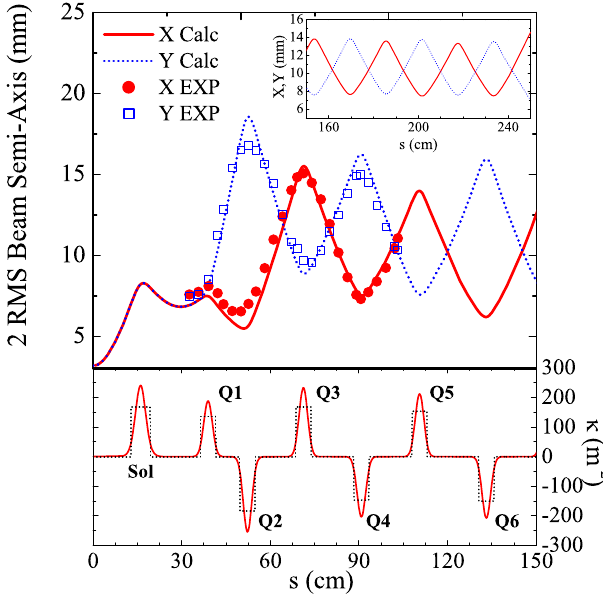
V).FIG. 8. (Color) Envelope-matching calculations for (cid:5) 72 : 92 (cid:12) (from SPOT ) vs experimental beam dimensions for a 100 mA, 10 keV, (cid:4) (cid:5) 60 (cid:10) m electron beam in UMER. The matching lattice consists of a short solenoid and six PC quadru- poles (see also last two columns in Table IV). The focusing function (one polarity shown) appears at the bottom, including the equivalent hard-edge representation. The inset illustrates the envelope calculated over 1 m along the periodic lattice, which starts at